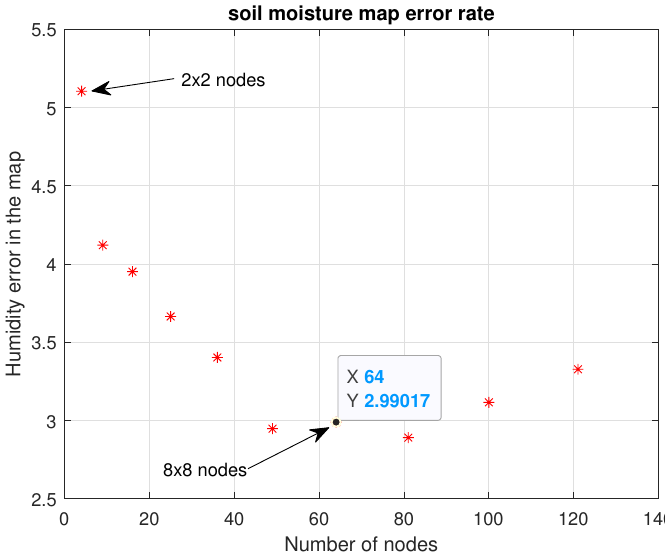
Figure 12. Error encountered for n × n nodes. First experimental